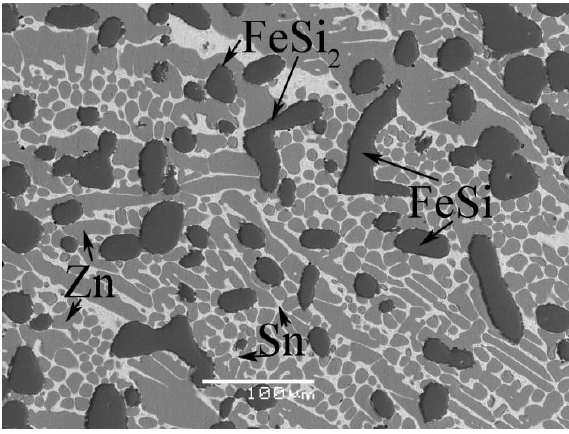
Figure 2. The microstructure of Alloy A1.